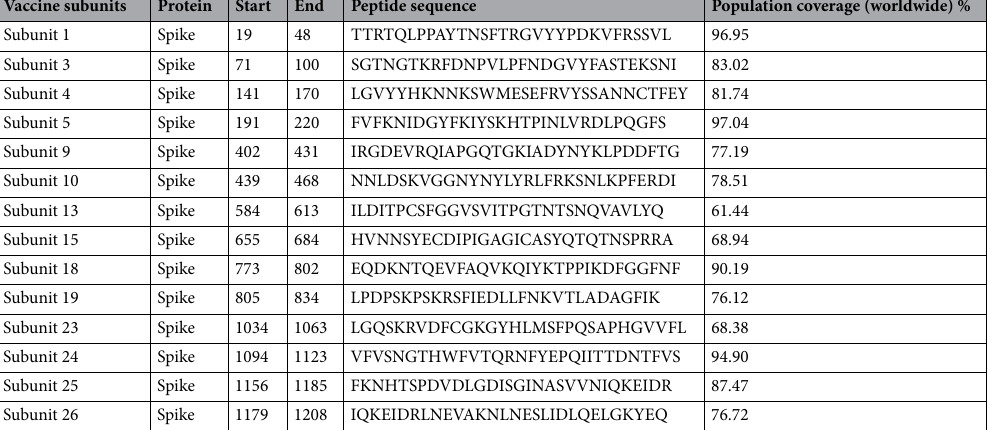
Table 8. Worldwide human population coverage analysis results.